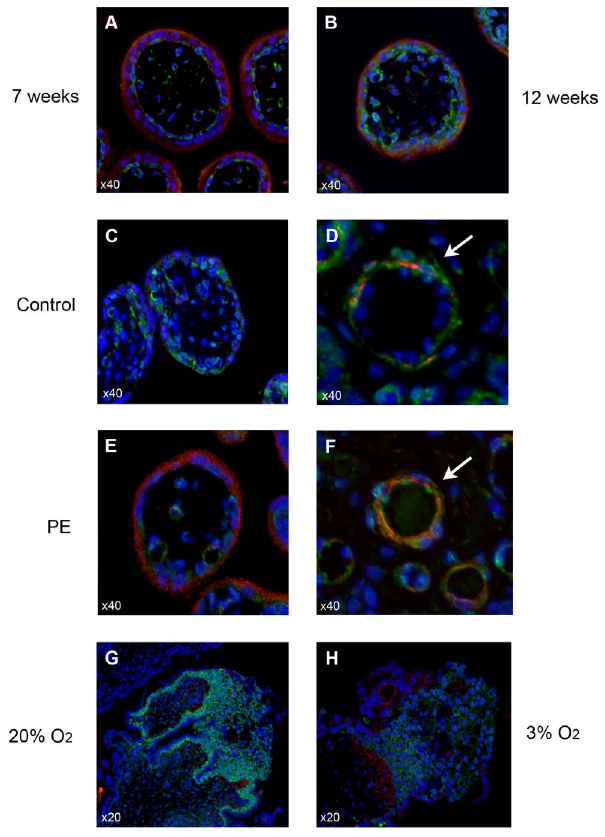
Figure 3. Immunofluorescence localization of sFlt-1 (red) and VEGFR-2 (green). Nuclear localization by DAPI staining is shown in blue. A: 7 weeks placenta B: 12 week placenta. C–D: control. E–F: early preeclampsia. G: first trimester villous explants at 20% oxygen and H: villous explants at 3% oxygen. Co-immunofluorescence is shown in yellow/orange. White arrow: vessel wall.